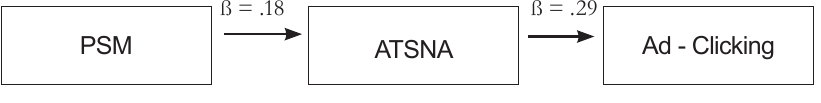
Fig. 2 – Structural Model. Source: